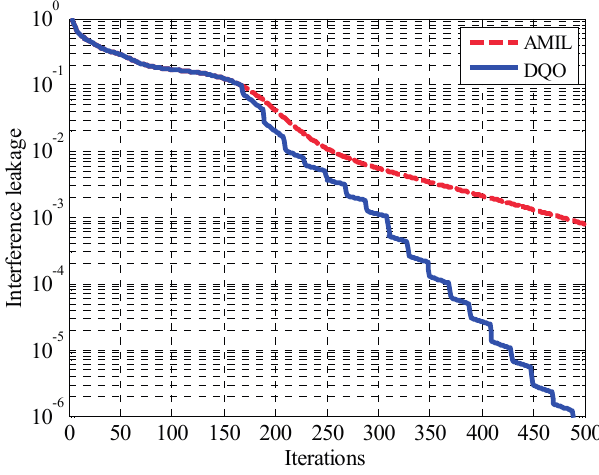
Figure 6. Convergence curves of the interference leakage for one realization of randomly generated channel coefficients in (5 × 5, 2) 4